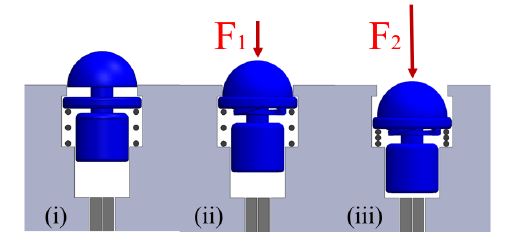
Figure 3. Compression of the tactile element: ( i ) no force is applied, the tactile element is not compressed; ( ii ) small force ( F 1 ) is applied, ortho-planar spring only is compressed; ( iii ) large force ( F 2 ) is applied, both ortho-planar and linear springs are